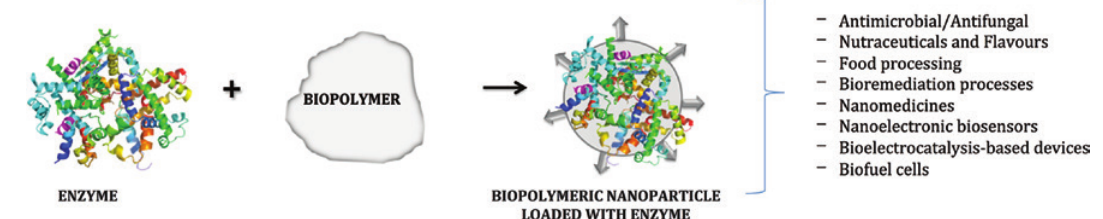
Figure 1: Biopolymer-based biocatalytic nanoparticle and their possible